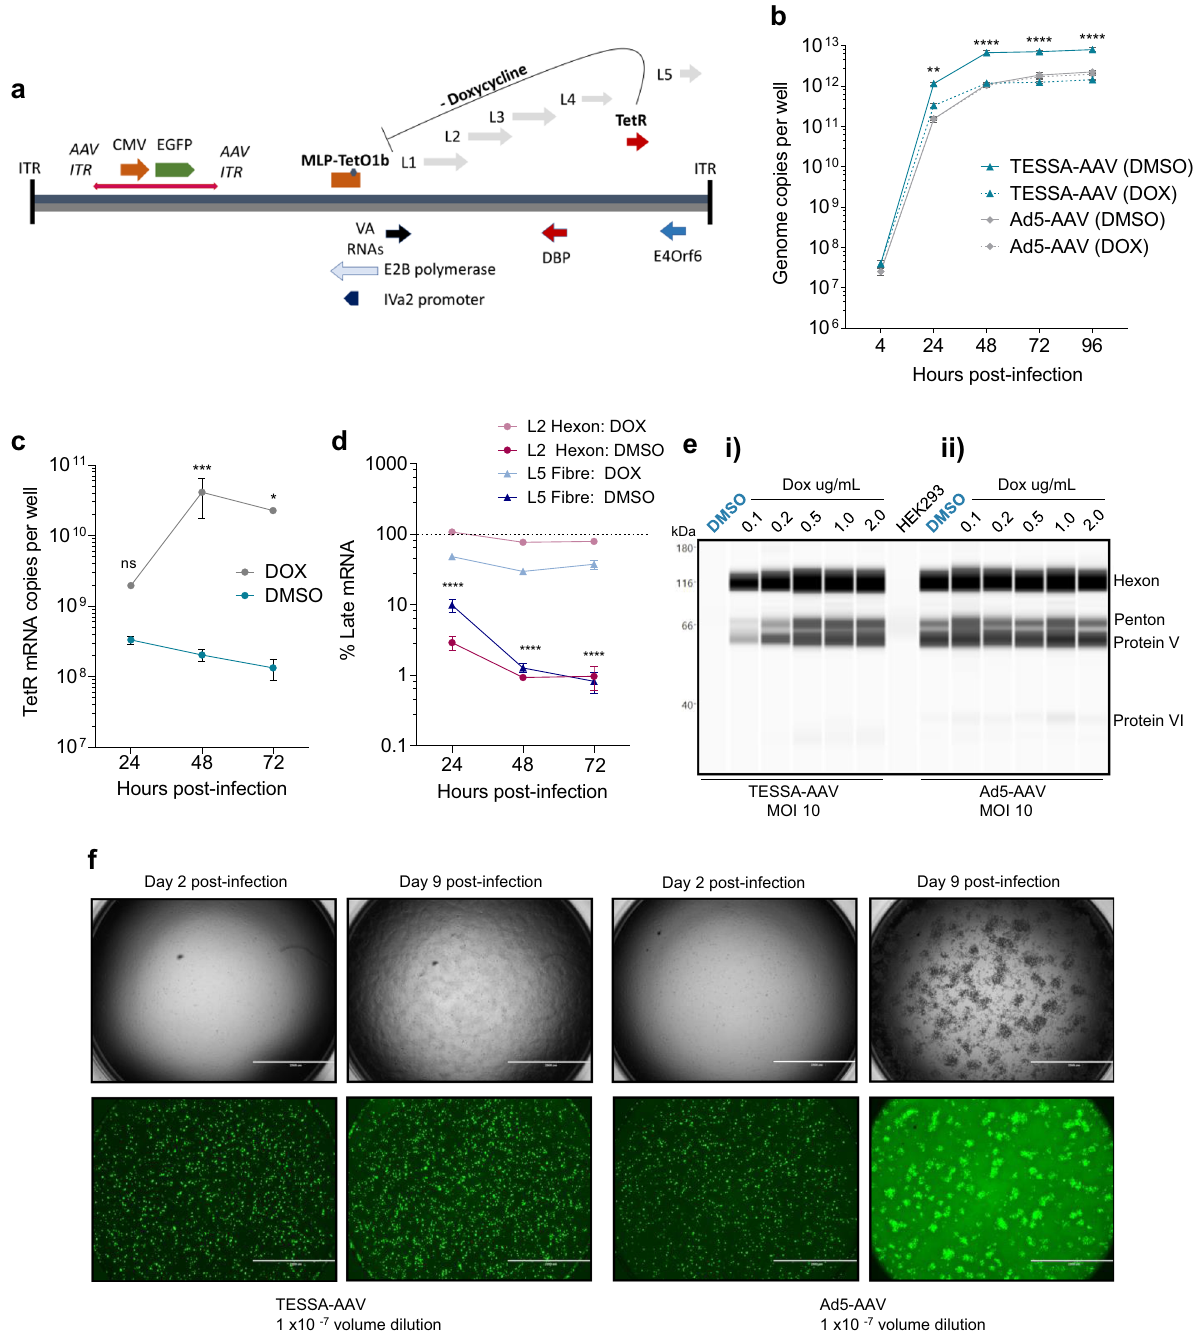
Fig. 1 TESSA-AAV represses late adenoviral proteins and virus spread. a Schematic of TESSA-AAV encoding an rAAV genome with a EGFP reporter in the E1-deleted region. b Comparison of genome replication, determined by fi bre-speci fi c qPCR, between TESSA-AAV and Ad5-AAV in HEK293 cells (MOI of 100) treated with doxycycline or DMSO. Data are N = 3 (mean ± SD) of biological replicates. Analysed by two-way ANOVA followed by Bonferroni post hoc test comparing TESSA-AAV (DMSO) versus Ad5-AAV (DMSO). ** p = 0.0019, **** p ≤ 0.0001. c Expression of TetR mRNA, as determined by RT- qPCR, from HEK293 cells infected with TESSA-AAV (MOI of 10) and treated with doxycycline or DMSO. Data are N = 3 (mean ± SD) of biological replicates. Analysed by two-way ANOVA followed by Bonferroni post hoc test comparing DMSO versus DOX group. * p = 0.0440, *** p = 0.0007. d Expression of Hexon and fi bre mRNA from TESSA-AAV (MOI of 10) in HEK293 cells treated with doxycycline or DMSO, as determined by RT-qPCR. Data are shown as the percentage of mRNA levels compared to the control Ad5-AAV. Data are N = 3 (mean ± SD) of biological replicates. Analysed by two-way ANOVA followed by Bonferroni post hoc test comparing L2 Hexon and L5 Fibre DMSO group against the DOX group. **** p ≤ 0.0001. e Western blot detection of adenovirus structural proteins from HEK293 cells infected with TESSA-AAV ( i ) or Ad5-AAV ( ii ) used at an MOI of 10, and treated with DMSO or escalating doses of doxycycline. f Representative images of HEK293 cells infected at a 1 × 10 − 7 volume dilution with TESSA-AAV versus Ad5-AAV. Cells were imaged at day 2 and day 9 post-infection. Scale bar, 1000 µ m. For panel e and f , data representative of at least three independent